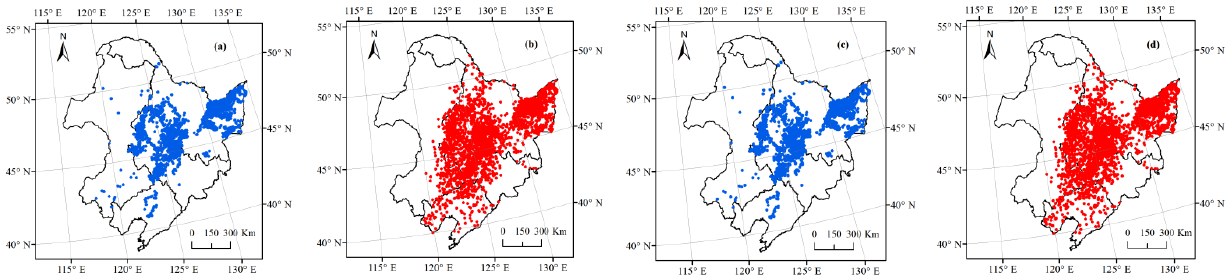
Figure 5. Comparison of the spatial distribution of fire points in Northeastern China according to MODIS observations (blue points) and BPNN verifications (red points) from 2013 – 2017. ( a , b ) only consider meteorological factors to forecast fire points as described in Section 3.1.1, whereas ( c , d ) also used soil moisture content and harvest date data to forecast fire points as described in Section 3.1.2.